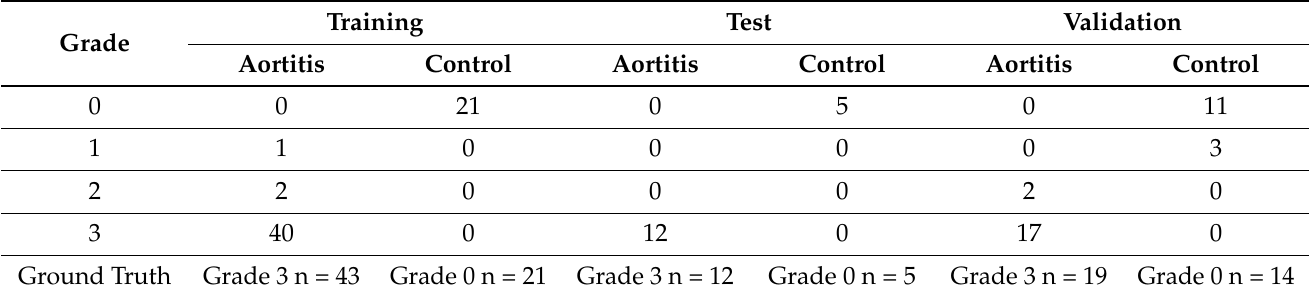
Table 3. Grading of patient dataset based on EANM/SNMMI guidelines [11]